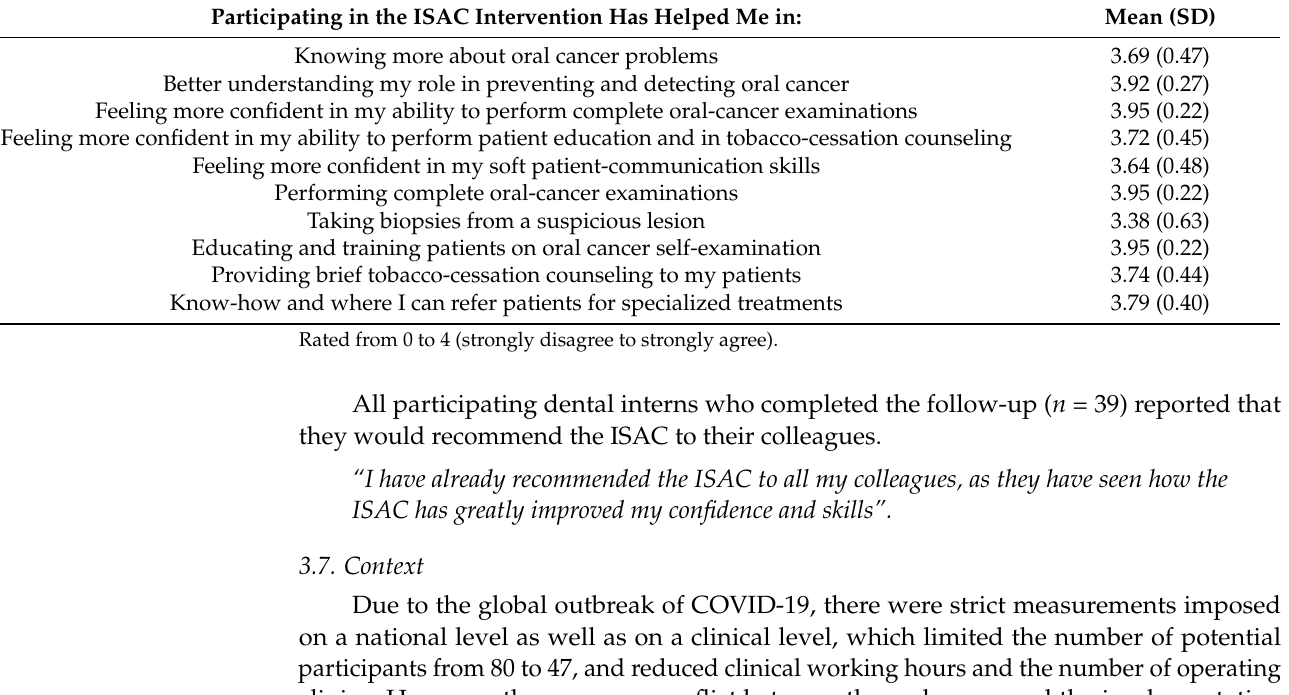
Table 3. Perceived effects from the ISAC participation ( n =